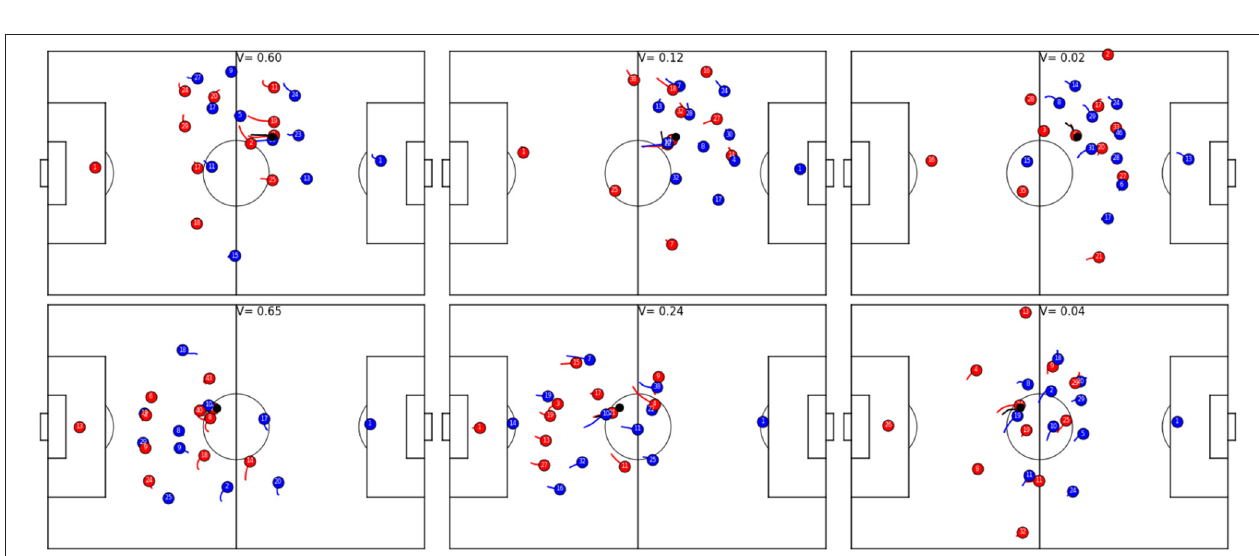
FIGURE 3 | Exemplary game situations and corresponding V from different games. Red is always in ball possession and plays from left to right, the ball is shown in black and always at the same position in each row. (Top row) : red is starting a 5 vs. 4 counter-attacks (left, V = 0.6); the defending team is more organized and has more players behind the ball, but red player 27 is available for potential through ball (center, V = 0.12); the defending team is fully organized and the chance of a successful attack is slim (right, V = 0.02). (Bottom row) : the beginning of a counter-attack, where the left flank of team red potentially allows for a 3 vs. 1 situation (left, V = 0.65); potential counter-attack but both strikers are well covered and blue defender 11 is available to cover an attacker (center, V = 0.24); a fully organized defense (right, V =